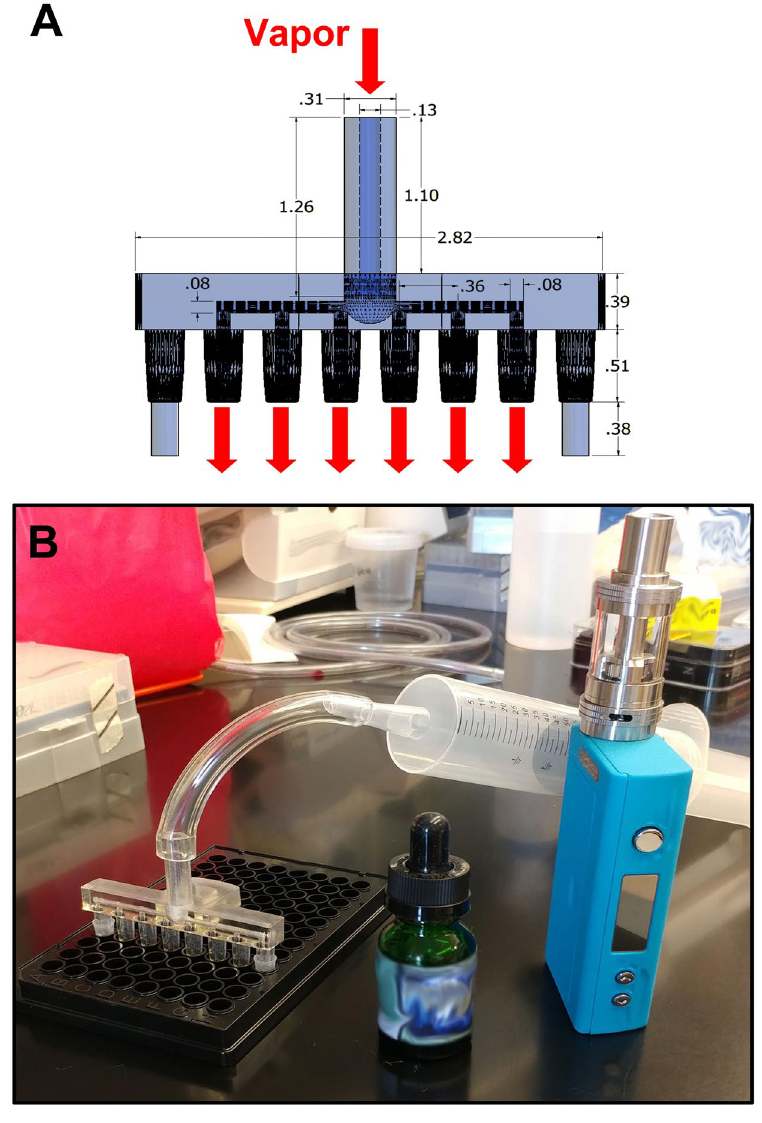
Figure 4. 3D printed, 6-channel manifold used to “vape” 6 wells per plate simultaneously. The adaptor was fabricated using a biocompatible Med610 resin and was connected to a third-generation mod to allows for “vaping” of 96 well plates. ( A ) Autocad-generated image, with dimensions given in inches. ( B ) Photograph of actual manifold next to 96 well plate and Sigelei FuChai 200W-TC device with a Crown stainless steel